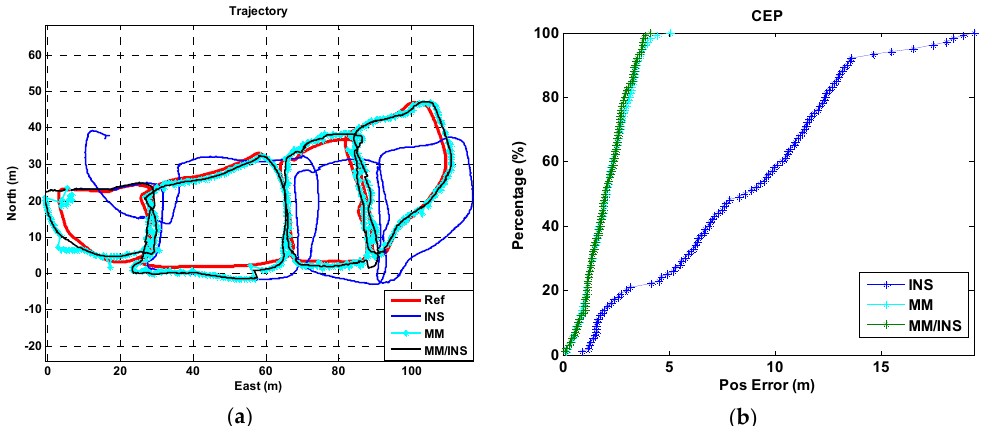
Figure 12. Navigation results of the INS, MM, and MM/INS solutions in building C (Test IV: Pedestrian III, Trajectory III, Google Pixel 2). ( a ) Trajectories; ( b ) cumulative error percentages. Table 1. Position errors of the INS, MM, MM/INS integrated methods for the four tests (units of m).